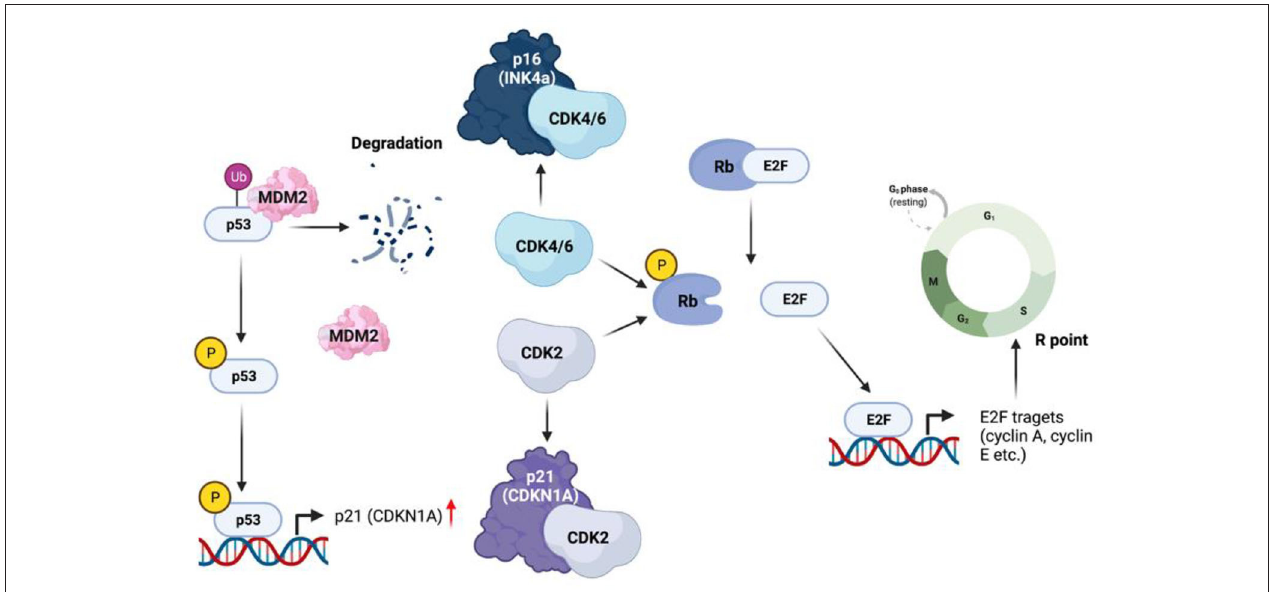
FIGURE 2 | SASP in